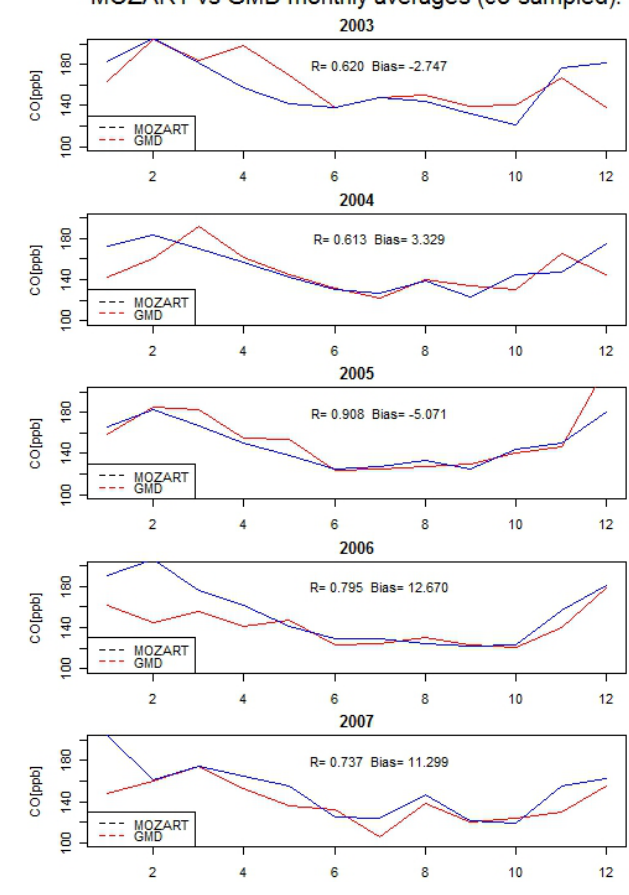
Fig. 7. Comparison of MOPITT V4 (blue dots) with MOZART (red dots) at 900mb, for the study period (2003–2007). The MOZART-4 results have been transformed with the MOPITT averaging kernels and a priori data.